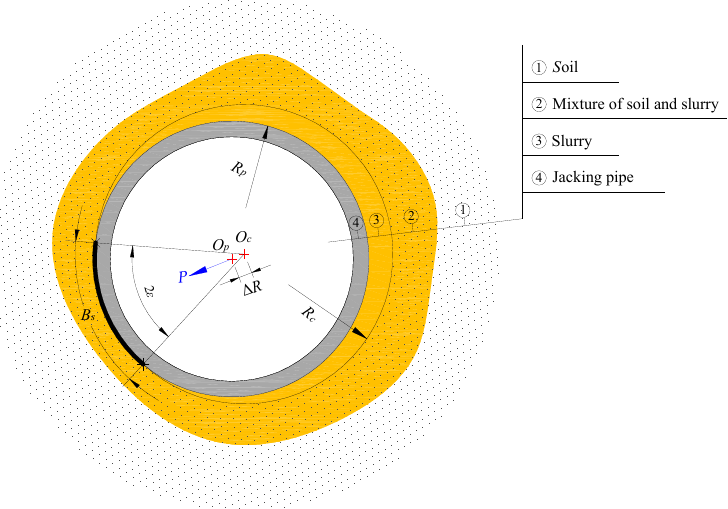
Figure 3. The general contact state of pipe-soil-slurry.